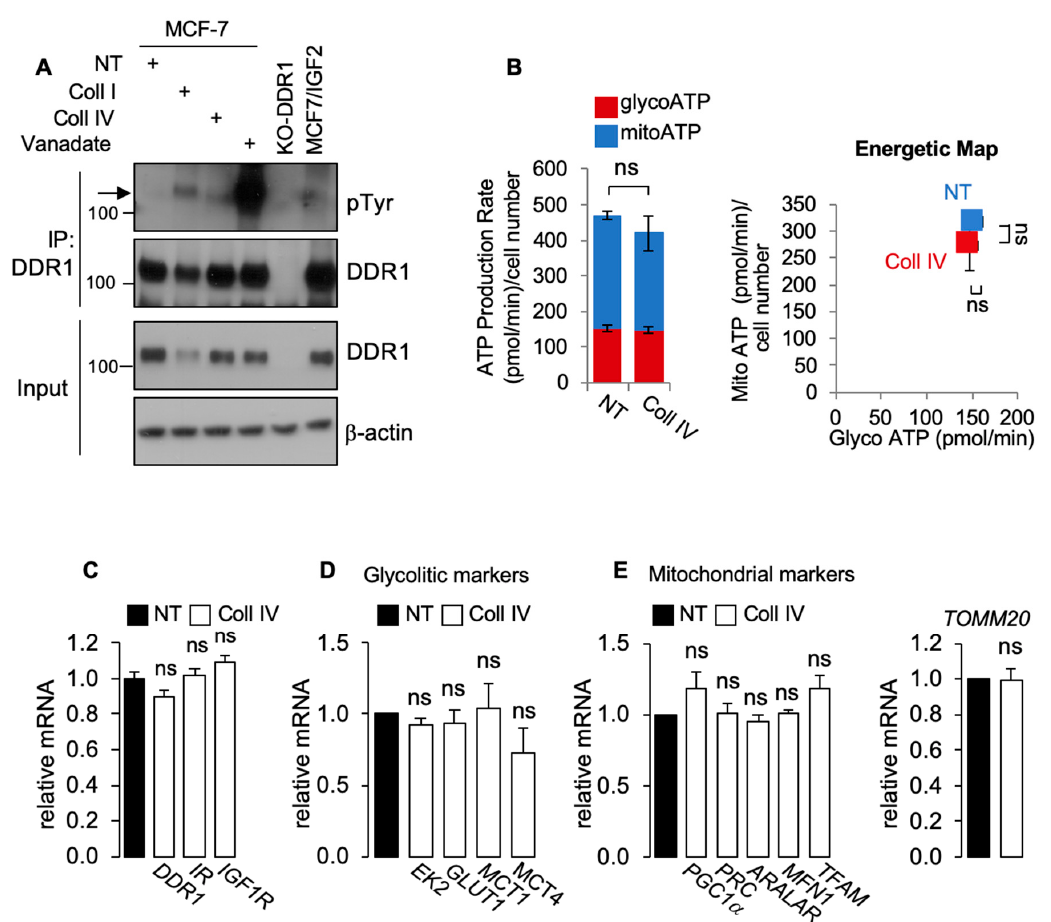
Figure 3. ( A ) MCF7 cells were exposed to 20 µg/mL of collagen I (Coll I) or collagen IV (Coll IV) for 6 h, and to 1mM of Na3VO4 (Van) for 90 min as positive control for DDR1 phosphorylation. Untreated cells were indicated as NT (not